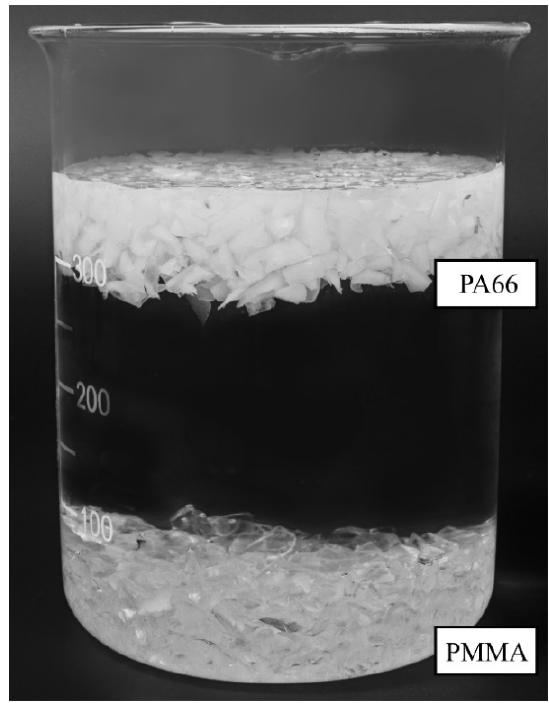
Figure 6. Exemplary picture of the fractionation by means of density differences.